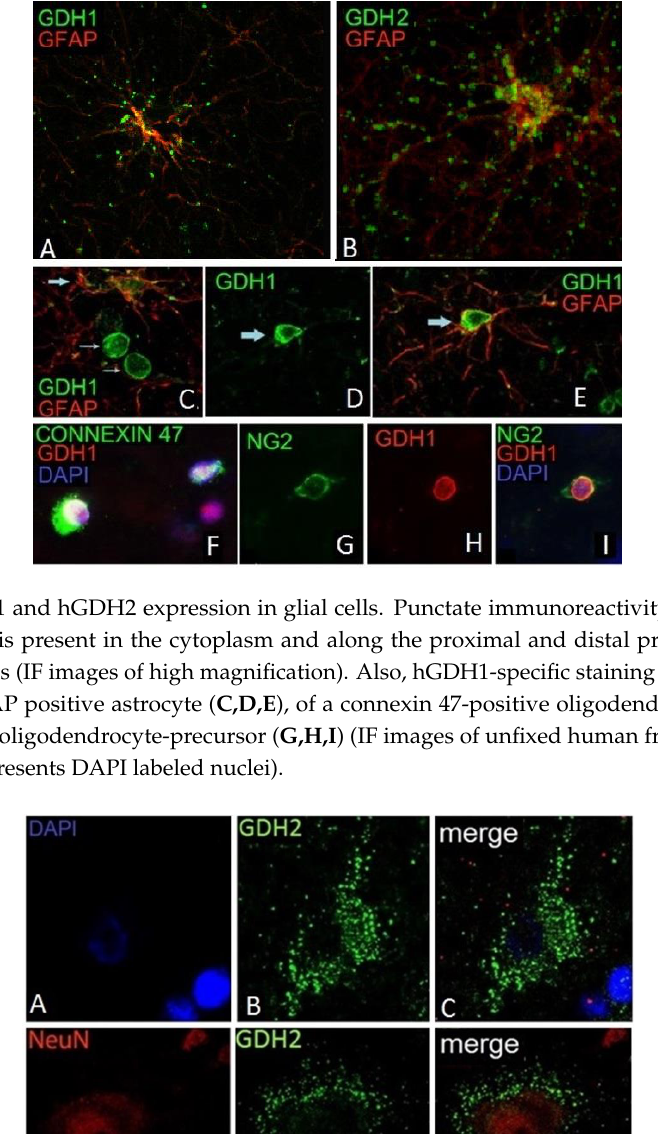
Figure 4. Localization of hGDH2-positive “puncta” in the periphery and in the perinuclear cytoplasmic area of large human cortical neurons. Specific hGDH2 punctate staining is observed in the cytoplasm of a large neuron from the occipital lobe within coarse structures resembling mitochondria ( A – C ). A constellation of intense hGDH2-specific “puncta” is also detected in the periphery of a sizable frontal lobe neuron with a large nucleus and prominent nucleolus ( D – F ). (IF images of unfixed human frontal and occipital lobe cortex. Blue staining represents DAPI labeled cell nuclei).